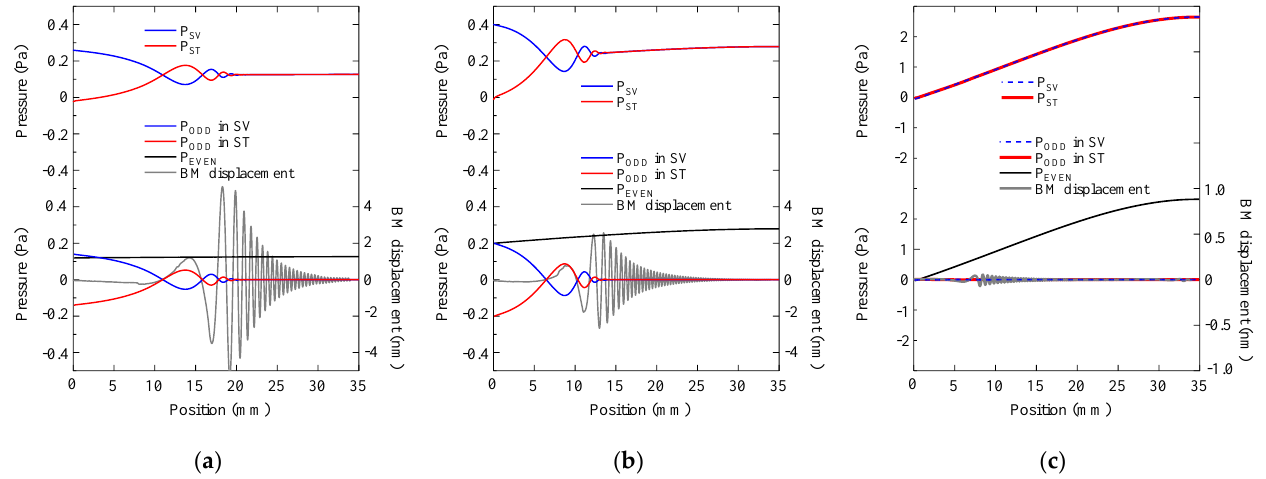
Figure 3. The upper graph shows the sound pressure levels in the scala vestibuli (in blue) and scala tympani (in red). The lower graph presents the sound pressure levels of the even mode (in black) and odd modes in the scala vestibuli (in blue) and scala tympani (in red), and the displace- ment of the basilar membrane (in light gray) when a continuous sinusoidal plane wave with a pressure level of 1 Pa was excited at the oval window. The horizontal axis shows the position in the cochlea. The observation times t = 30.096 ms, 38.840 ms, and 21.090 ms were chosen by trial and error so that the waveform swing P EVEN became the maximum after the waveform reached a steady state. ( a ) f = 2000 Hz, t = 30.096 ms. ( b ) f = 5000 Hz, t = 38.840 ms. ( c ) f = 10,600 Hz, t = 21.090 ms.